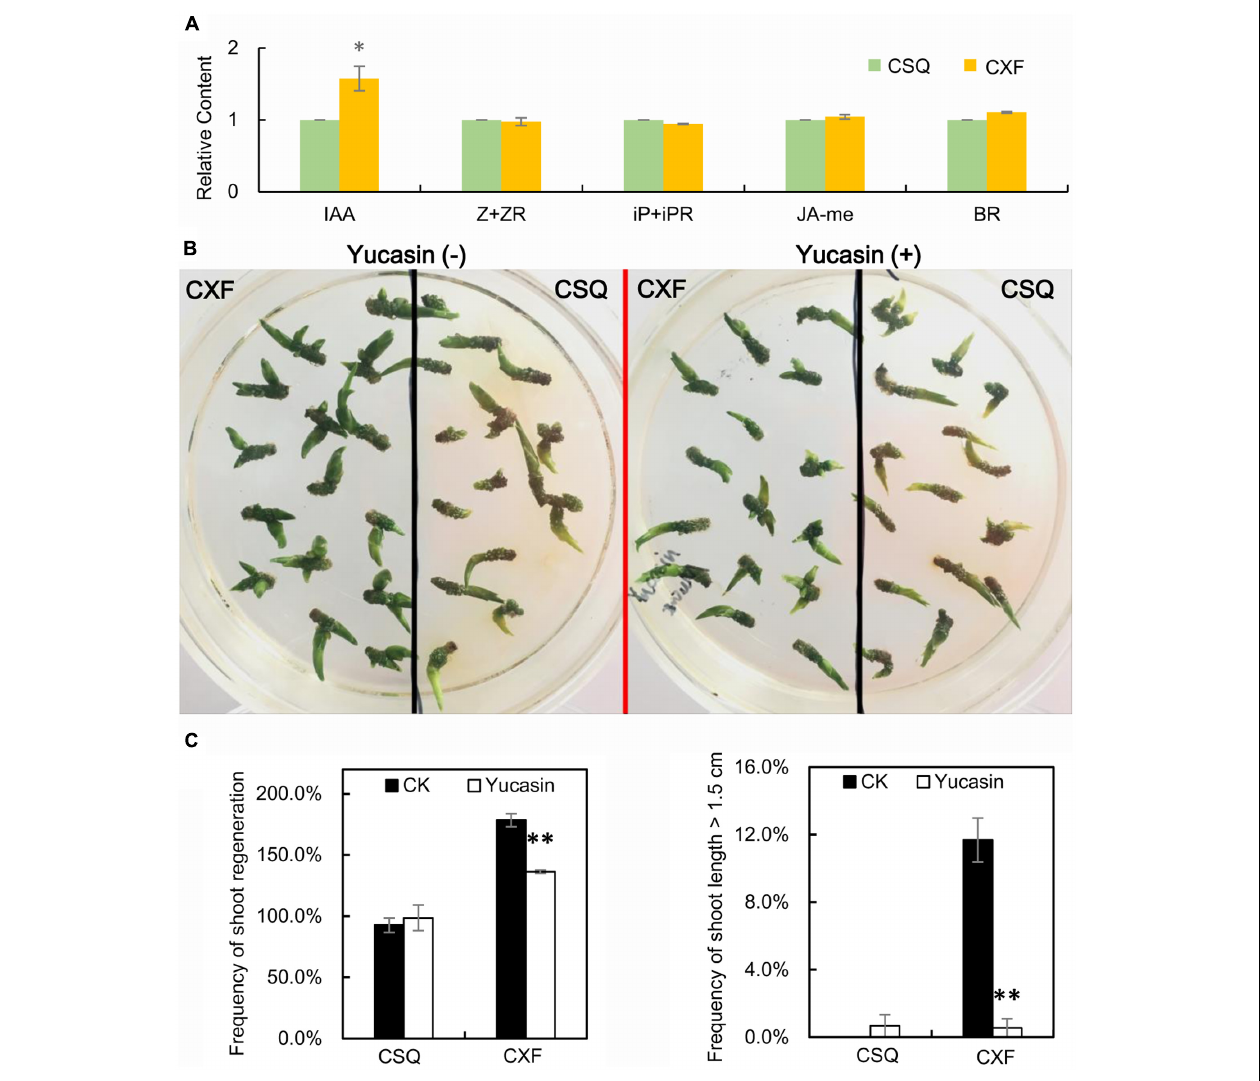
FIGURE 6 | Auxin is involved in shoot regeneration of rhizomes in Cymbidium . (A) Relative content of endogenous phytohormone of rhizomes on SIM at stage 1. IAA, endogenous indole-3-acetic acid; Z + ZR, endogenous zeatin with zeatin riboside; iP + iPR, endogenous N 6 -isopentenyladenine with N 6 -isopentenyladenosine; BR, endogenous brassinosteroids; JA-me, endogenous methyl jasmonate. Three biological replicates; asterisks indicate significant differences between CXF and CSQ ( ∗ P < 0.05; Student’s t -test). (B) Effect of yucasin on phenotypes of CXF and CSQ grown on SIM for 60 days. (C) Effect of yucasin on regeneration and growth of shoots of CXF and CSQ grown on SIM for 60 days. Three biological replicates, 45 rhizomes per replicate, were examined. Asterisks indicate significant differences from control ( ∗ P < 0.05; ∗∗ P < 0.01; Student’s t